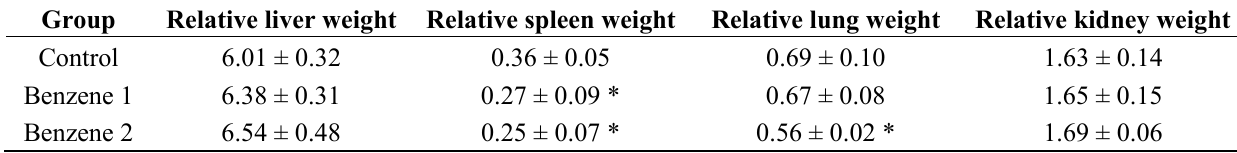
Table 1. Relative organ weights of male C3H/He mice on benzene exposure day 7.